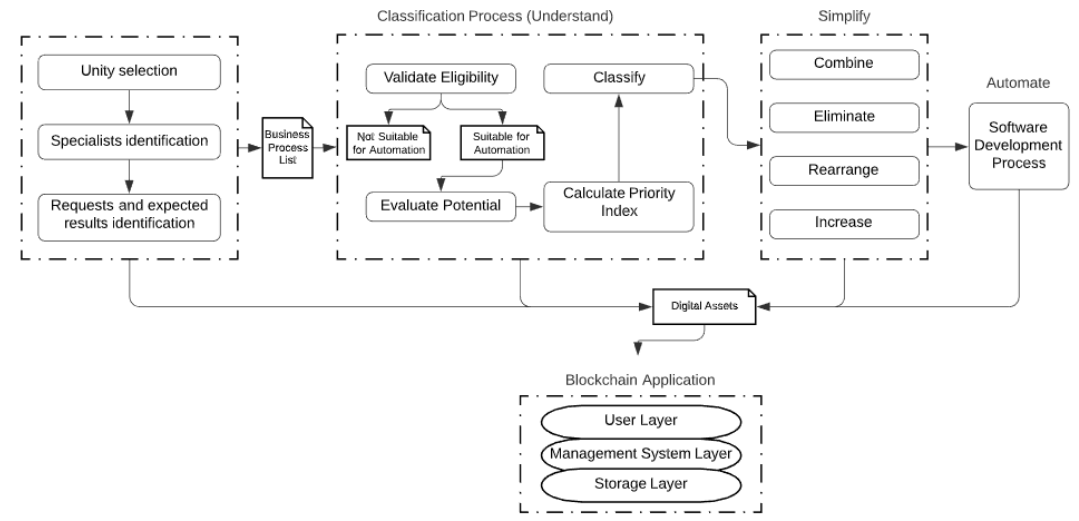
Figure 5. Illustration of the overall approach.